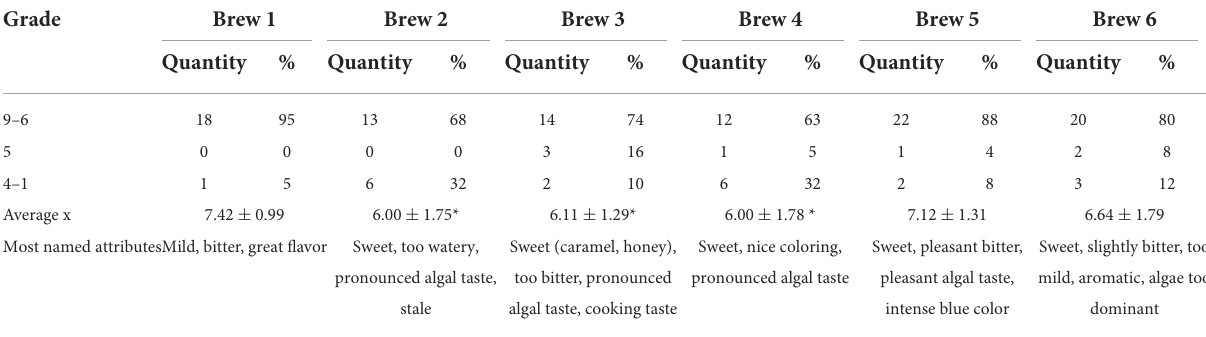
TABLE 3 Evaluation of the popularity of all beers with reference to the normalized grade area. Grade